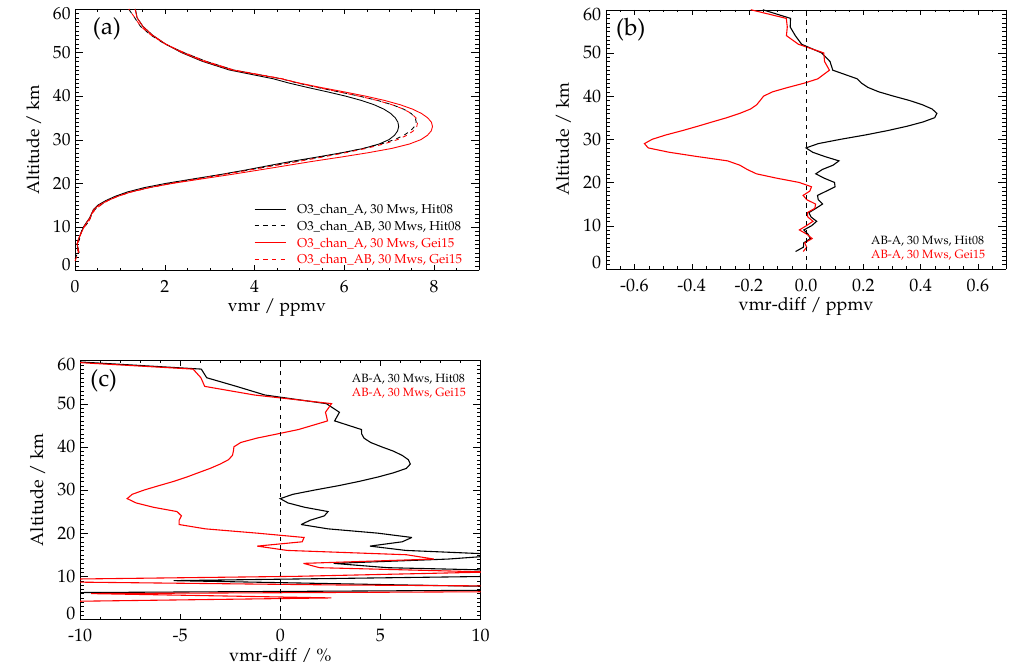
Figure 6. (a) Mean ozone profiles retrieved in MIPAS channels A (solid lines) and AB (dashed lines) using the HITRAN-2008 (black) and GEISA-2015 spectroscopy (red). The profiles are averages over 59 orbits from 3 January, 1 April, 2 July and 2–3 October 2009. (b) Absolute and (c) relative differences between the profiles retrieved in channels AB and A using HITRAN-2008 (black) and GEISA-2015 (red).